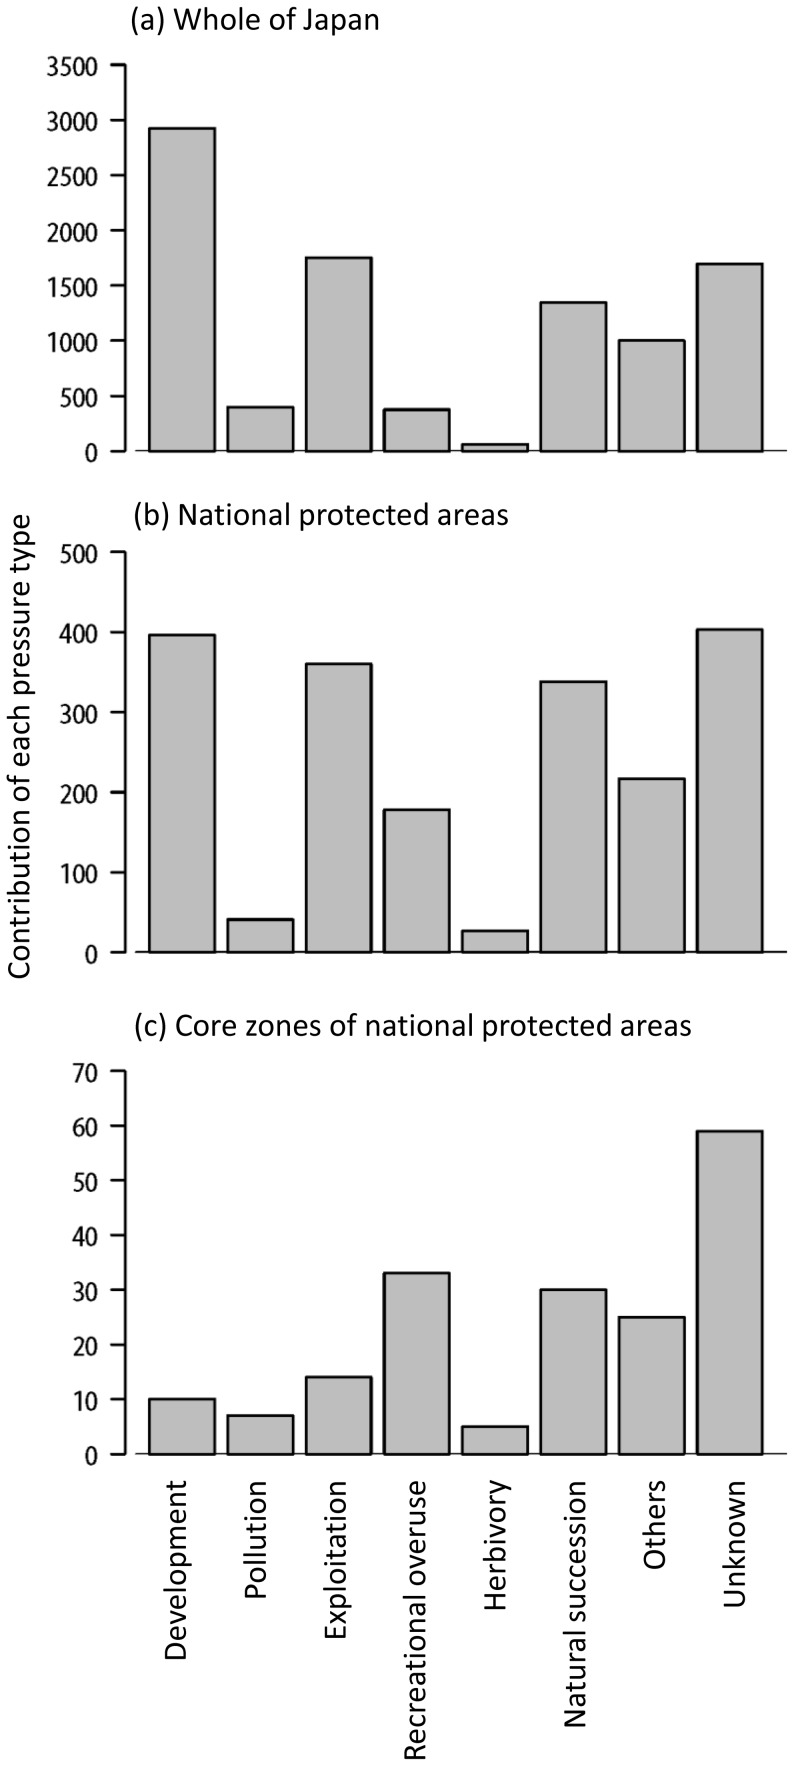
Contribution of pressure types causing decline of local populations in (a) whole of Japan, (b) national protected areas (cells with >20% of protected areas) and (c) core zones of national protected area (cells with >20% of core zones).For each combination of pressure type and species, the number of cells with declining population was calculated, and the numbers are summed for each pressure type.